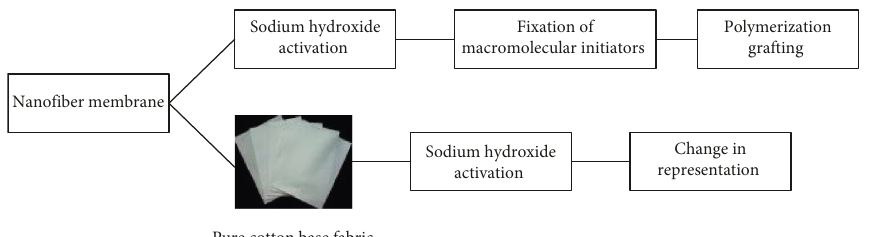
Figure 3: Preparation process of stretchable nanofiber